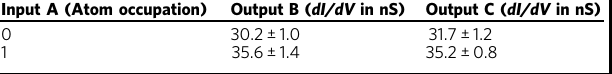
Table 2 The relation between the outputs and input for pseudo FANOUT